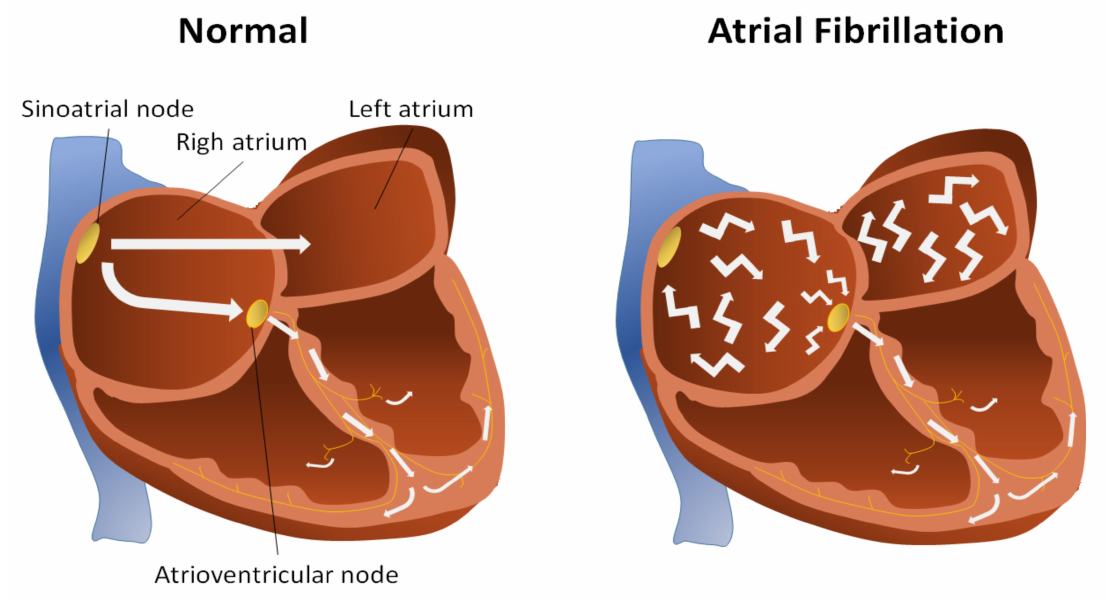
Figure 1. Cardiac electric signals in normal and AF heart.